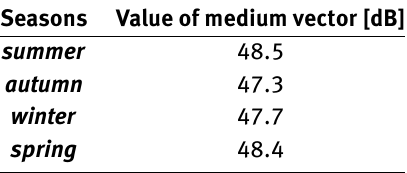
Table 4: The value of average vectors defining sound level in each seasons.